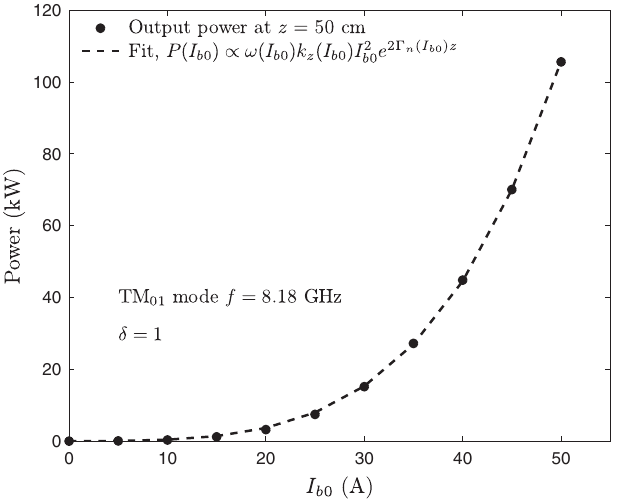
FIG. 22. Group velocity for a 50 A beam with (cid:1) ¼ 1 from the FIG. 20. Scaling of SASE power in the linear regime at z ¼ dispersion relation in Fig. 4. The unstable branch of the disper- 0 : 5 meter with a beam current for the TM 01 mode. sion relation is shown in the dashed line.